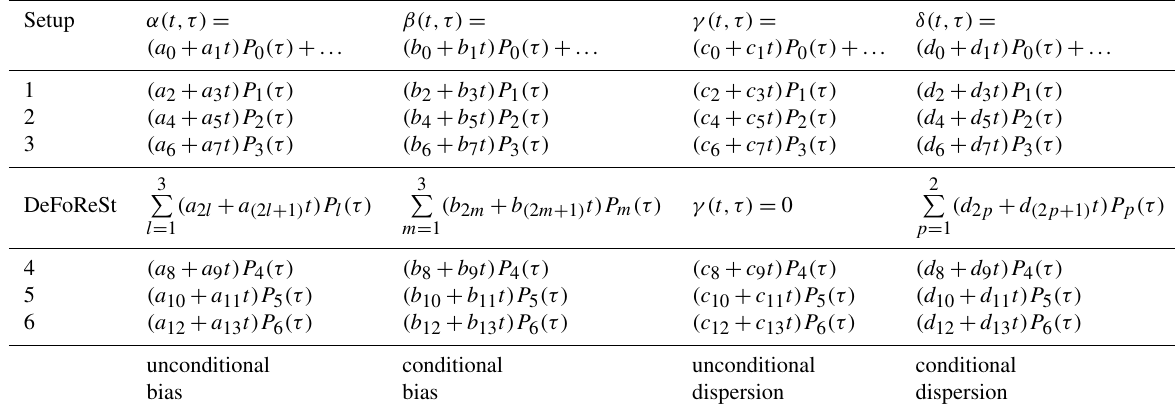
Table 1. Overview of the different toy model setups and the corresponding polynomial lead time dependencies.